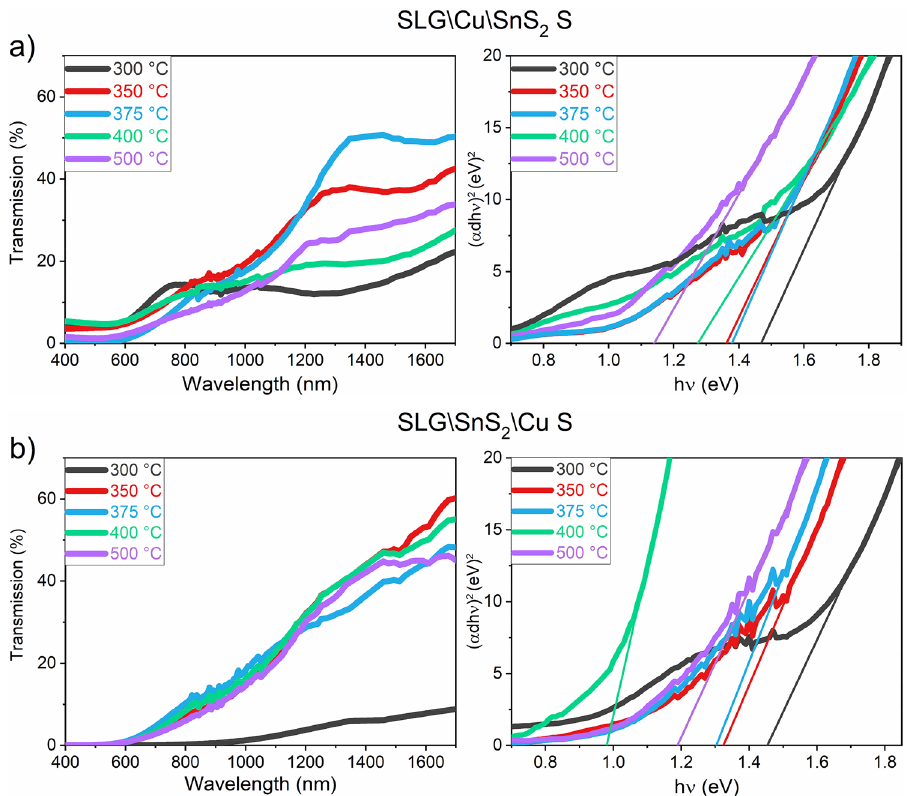
Figure 14. Transmission and Tauc plot of the CTS films annealed under S atmosphere at different temperatures. ( a ) SLG\Cu\SnS 2 S and ( b ) SLG\SnS 2 \Cu S